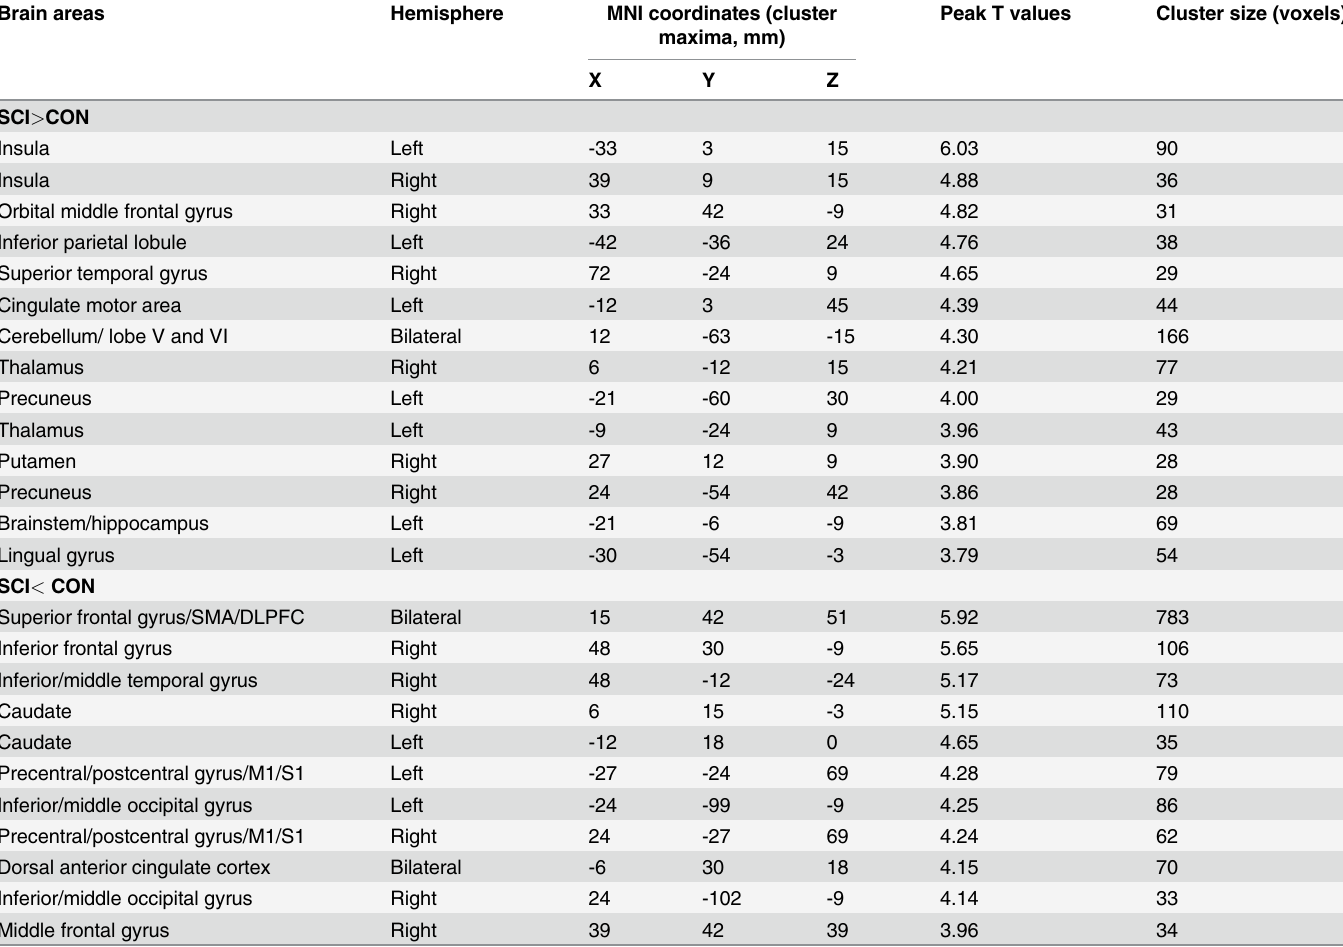
Table 2. Brain areas with altered ReHo compared with healthy controls (Alphasim corrected, p alpha <